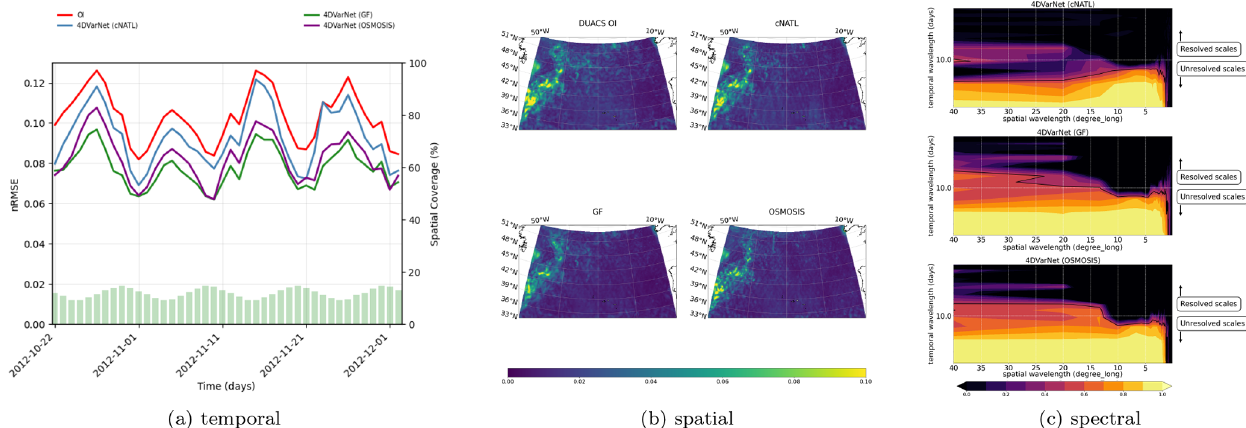
Figure B3. 4DVarNet generalization capabilities (cNATL), with the spatial, temporal, and spectral performance on the BOOST-SWOT DC evaluation period, based on the three different training domains of cNATL, GULFSTREAM, and OSMOSIS.